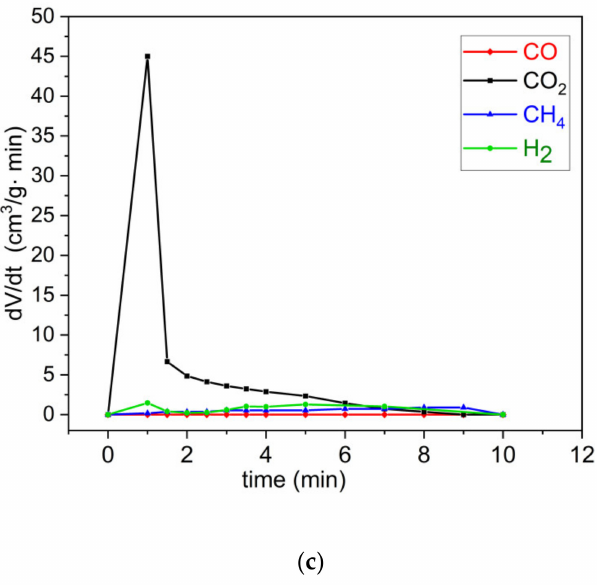
Figure 11. ( a ) Curves of evolution rate of gaseous products (CO, CO 2 , H 4 , and H 2 ) of charred pistachio sample P850 at a temperature of 850 ◦ C, as determined by volumetric method. ( b ) Curves of evolution rate of gaseous products (CO, CO 2 , H 4 , and H 2 ) of Charcoal CH-M (Merck, Darmstadt, Germany) at a temperature of 850 ◦ C, as determined by volumetric method. ( c ) Curves of evolution rate of gaseous products (CO, CO 2 , H 4 , and H 2 ) of Carbon Black CB-221 at a temperature of 850 ◦ C, as determined by volumetric method.